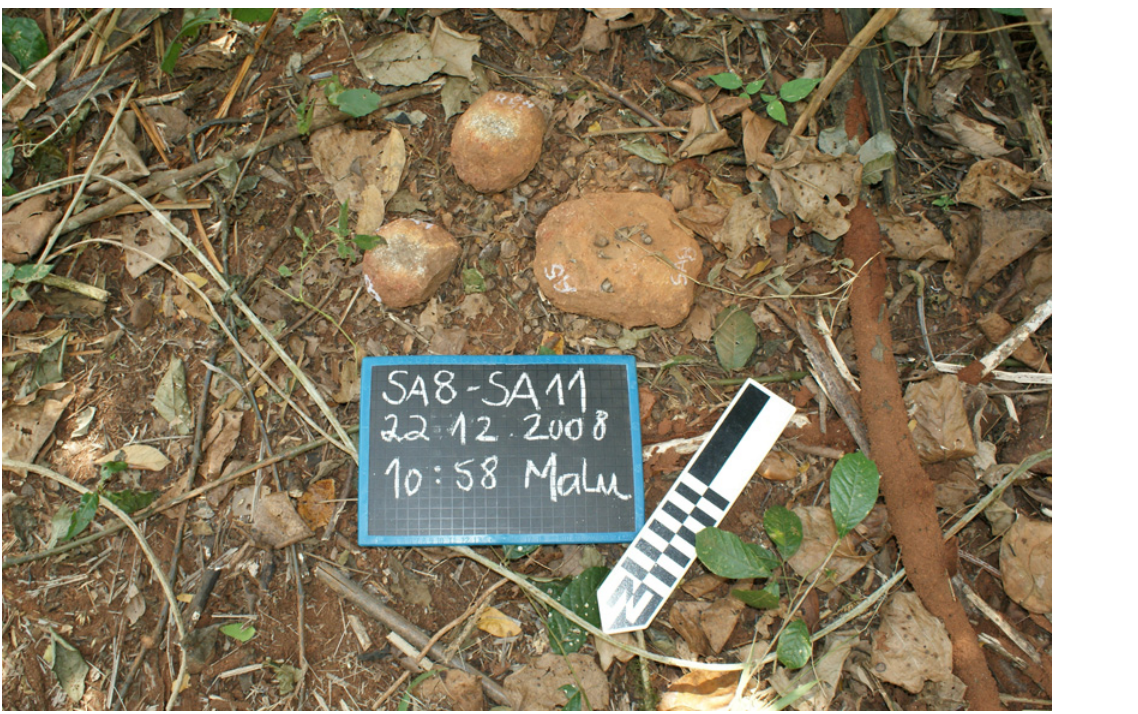
Fig 2. View of a natural nut-cracking site in Bossou forest, with tools 4 and 5 analysed in this study.